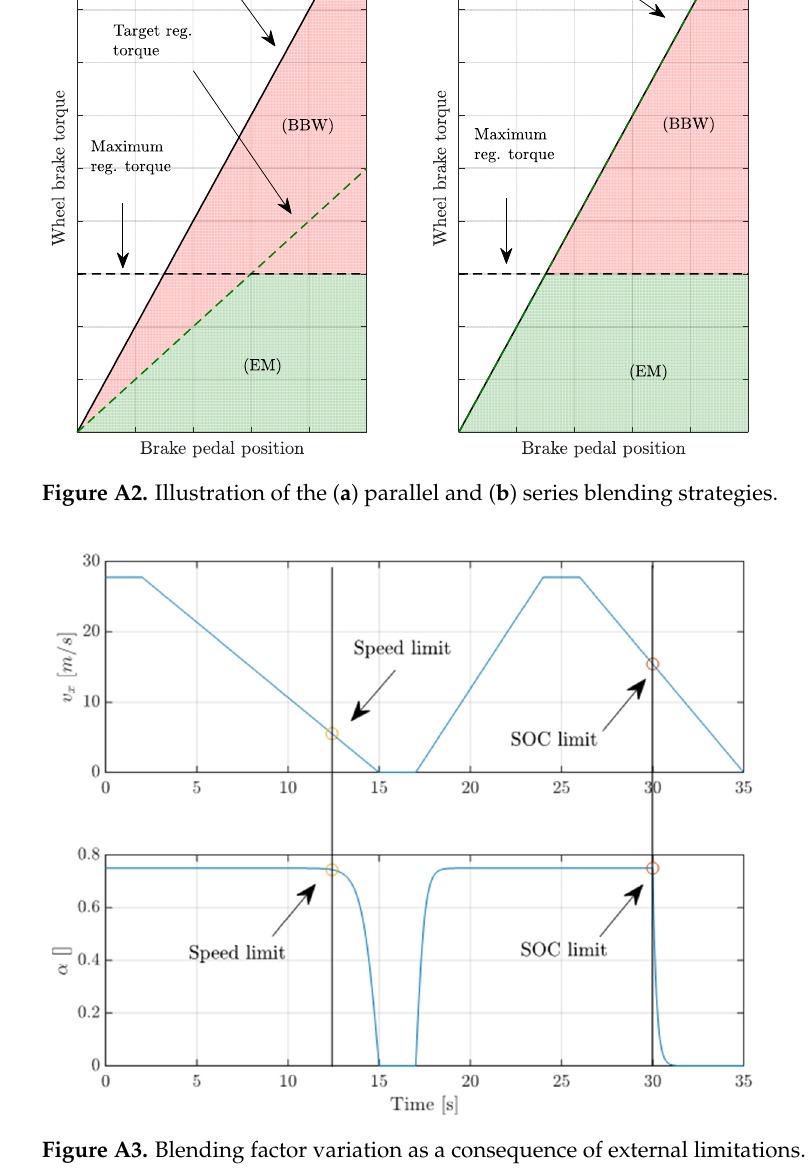
Figure A3. Blending factor variation as a consequence of external limitations.